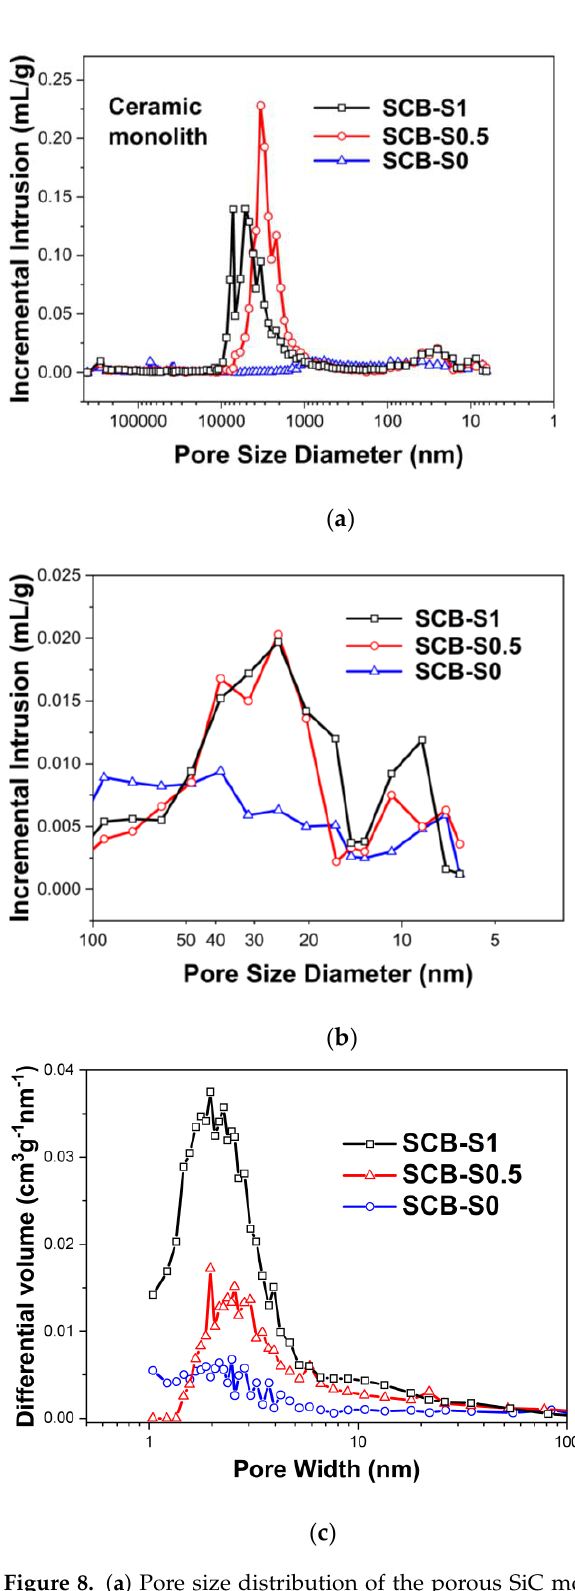
Figure 8. ( a ) Pore size distribution of the porous SiC monoliths after being heated at 1400 °C in vacuum for 1 h. ( b ) Expanded view of the pore size distribution curves in the nanometer scale. ( c ) Pore size distribution of the porous SiC monoliths obtained via nitrogen sorption method.